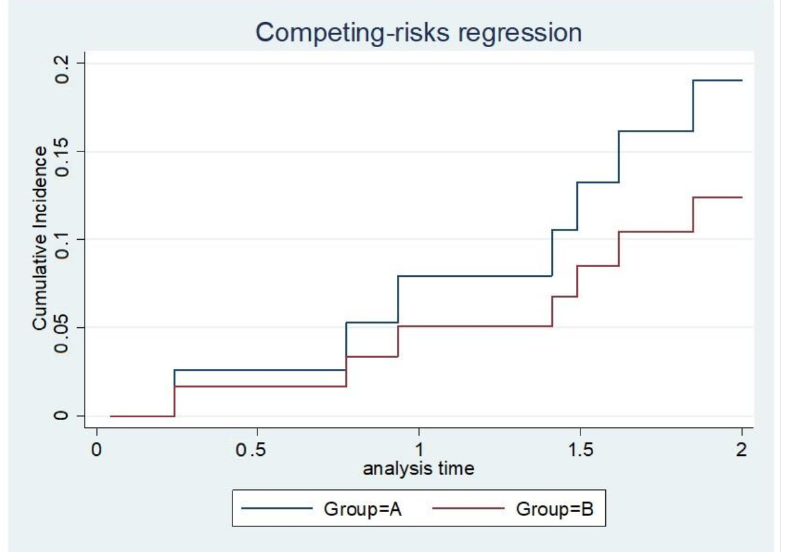
Figure 5. Competing risk regression. Analysis time